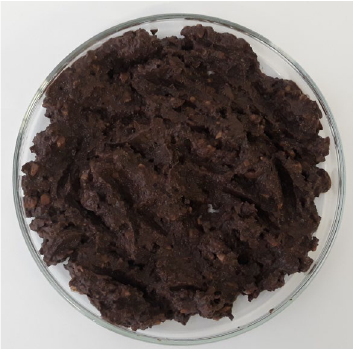
Figure 1. O live pomace sample .